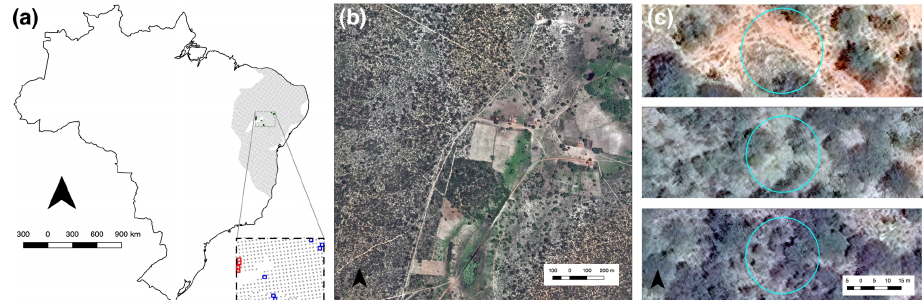
Figure 2. Study Region and labeling examples. ( a ) the semi-arid Sertão lies in northeast Brazil (grey region). We sampled ten 100 km 2 regions, constrained by availability of WorldView imagery. The zoomed inset shows the ten regions. Four (red) had imagery available from March, and the other six (blue) had imagery available from September; ( b ) a 1 km × 1 km area from one of the 10 regions, showing landscape heterogeneity. We labeled (and then classified) examples as either trees (meant to capture more permanent vegetation), shrubs (meant to capture smaller, seasonal vegetation), and bare land (no vegetation); ( c ) in each region, 1000 examples were labeled according to (i) the class of the corresponding high-resolution WorldView pixel of the exact location (red point), and (ii) the majority class of all WorldView pixels within a 30 m diameter buffer (cyan ring). The examples shown here were labeled as bare land (top), shrub (middle), and tree (bottom) in both point and buffer labeling schemas. Grey stippled points in the map are the sampling regions from ( a ), drawn from [10], and the dashed bounding box is the area used for comparison to their treecover